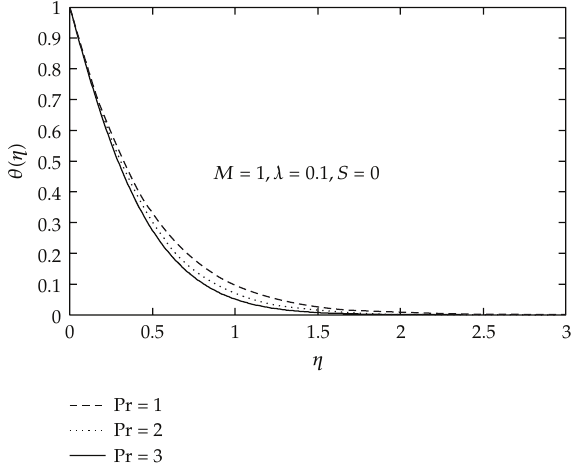
Figure 4: Variation of temperature θ (cid:6) η (cid:7) with η for several values of the Prandtl number Pr when M (cid:9) 1, λ (cid:9) 0 . 1, and S (cid:9)